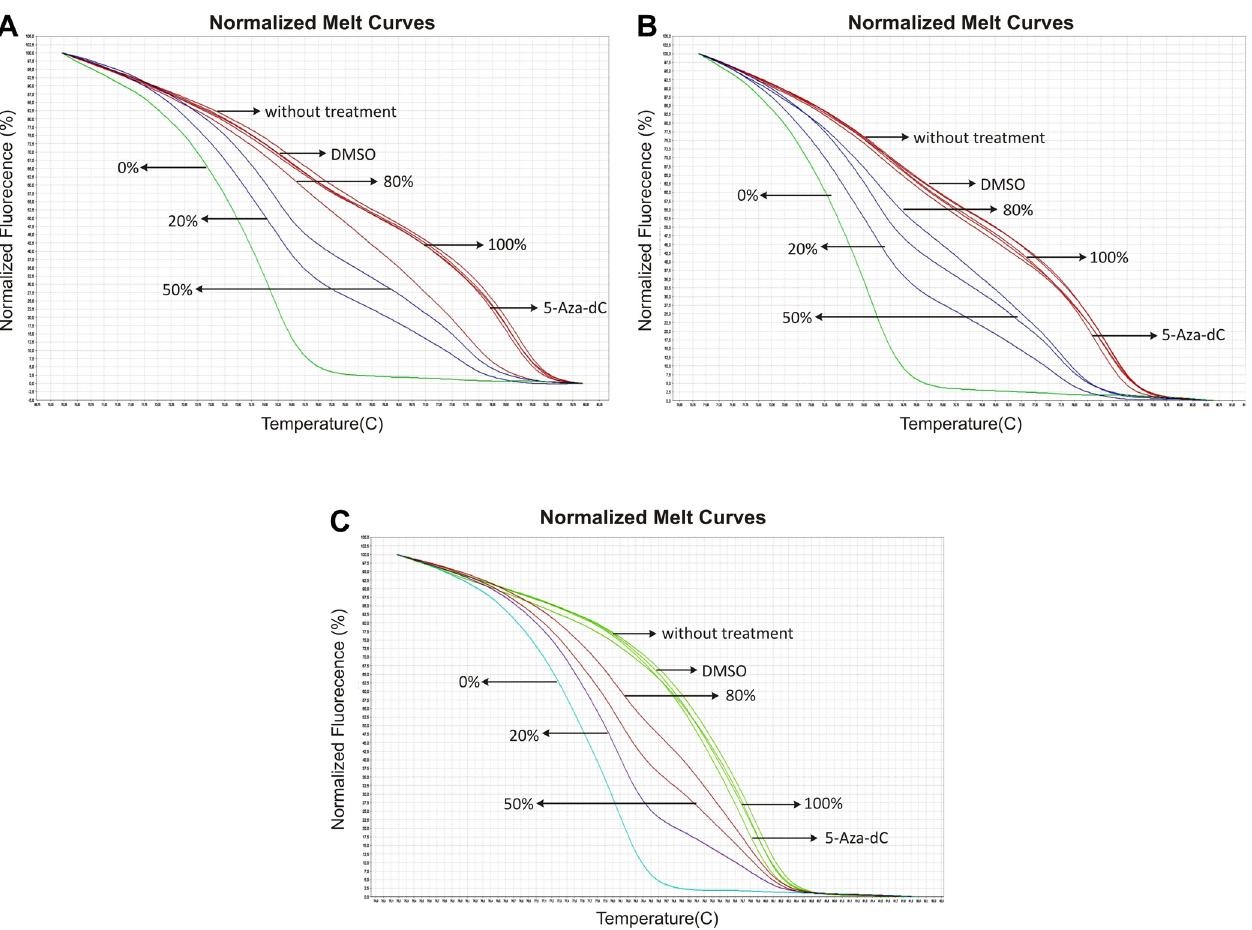
Fig 5. 5-Aza-2-deoxycytidine (5-Aza-dC) treatment does not affect methylation status of the CpG islands near to putative promoter region of both genes. Representative normalized melt curves from samples treated with demethylating agent 5-Aza-dC. A-B. DNA analyzed from the CpG island at the promoter region of MIR503HG gene in DLD1 (a) and HCC1954 (b) cell lines. C. DNA analyzed from the CpG island at the promoter region of LINC00629 gene in DLD1 cell line. Arrows indicate curves that correspond the percentage of methylation from reference, treatment, and control DNA samples. Images were obtained from High-ReSolution Melt Software